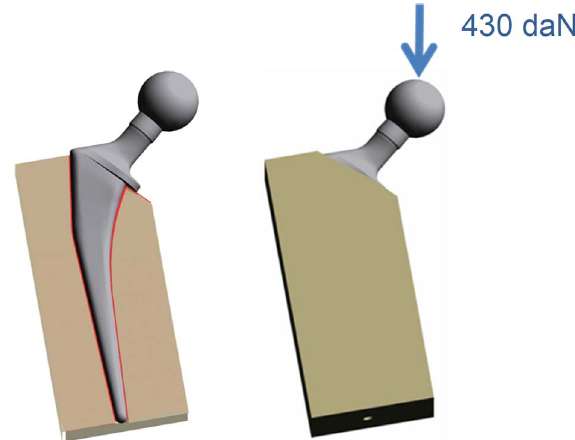
Figure 2. Model principle and loading of the stem which is introduced in a bloc with the same mechanical properties as cortical